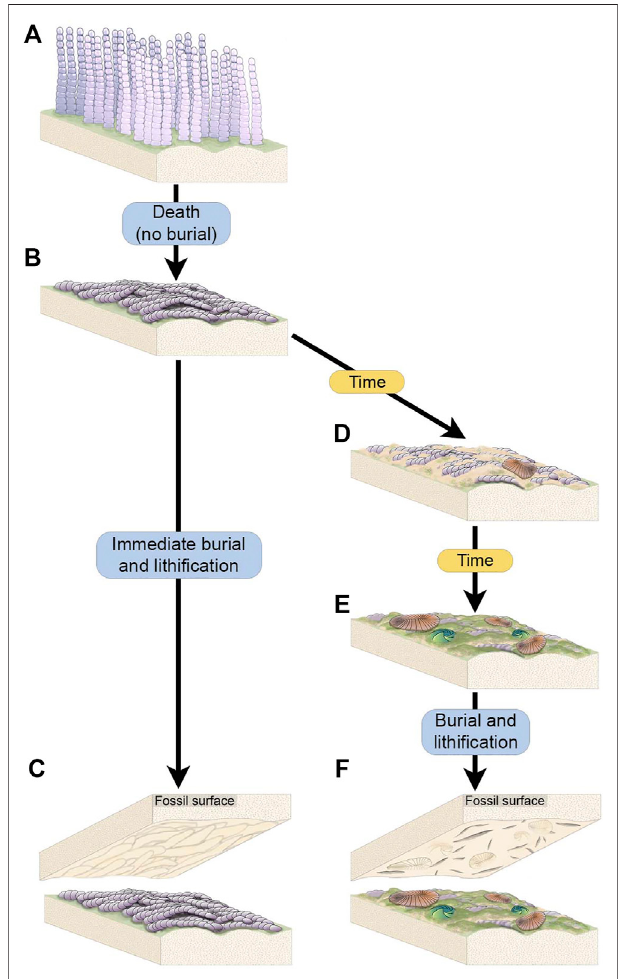
FIGURE 7 | Schematic of the two scenarios through which complex Funisia dorothea TOS is hypothesized to have formed. (A) A living community of densely packed individuals of Funisia. (B) Death of the Funisia population in the absence of sediment deposition, creating a thick TOS. (C) The Funisia population is buried soon after death, resulting in the casting of the Funisia TOSonthebaseofthedepositionalevent. (D) Inanalternatescenario, the dead Funisia population remains unburied on the sea fl oor for an ecologicallysigni fi cantperiodoftime,backgroundsedimentationoccurs and mobile organisms begin to colonize the surface. (E) The dead Funisia populationremains exposed on thesea fl oorand Funisia beginto decay while new TOS begins to form on top. More macroorganisms, including sessile taxa, begin tocolonize thedecaying Funisia surface. (F) The fossil surface resulting from the burial of this time averaged Funisia surface preserves the TOS “ Groove ” , representing the build up of sediment and TOS between decaying Funisia associated with a community of mobile and sessile macroorganisms.